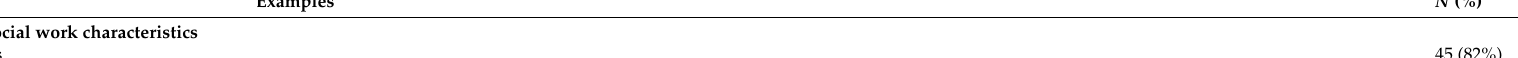
Table 1. Frames of reference for global ratings of job stressfulness and the number and percentage of participants identifying each referent ( N = 55).